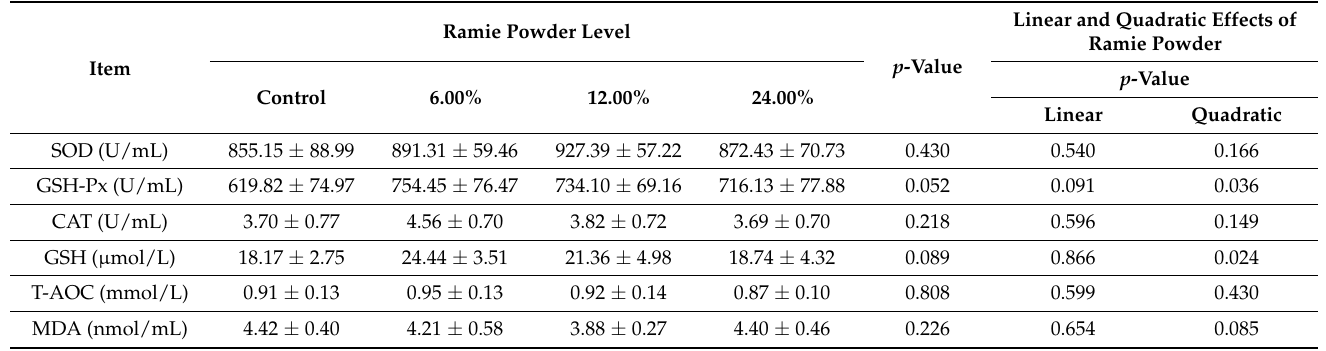
Table 7. Effect of the different ramie powder levels in the diets on the serum antioxidant indices of 98 days old Yanling white